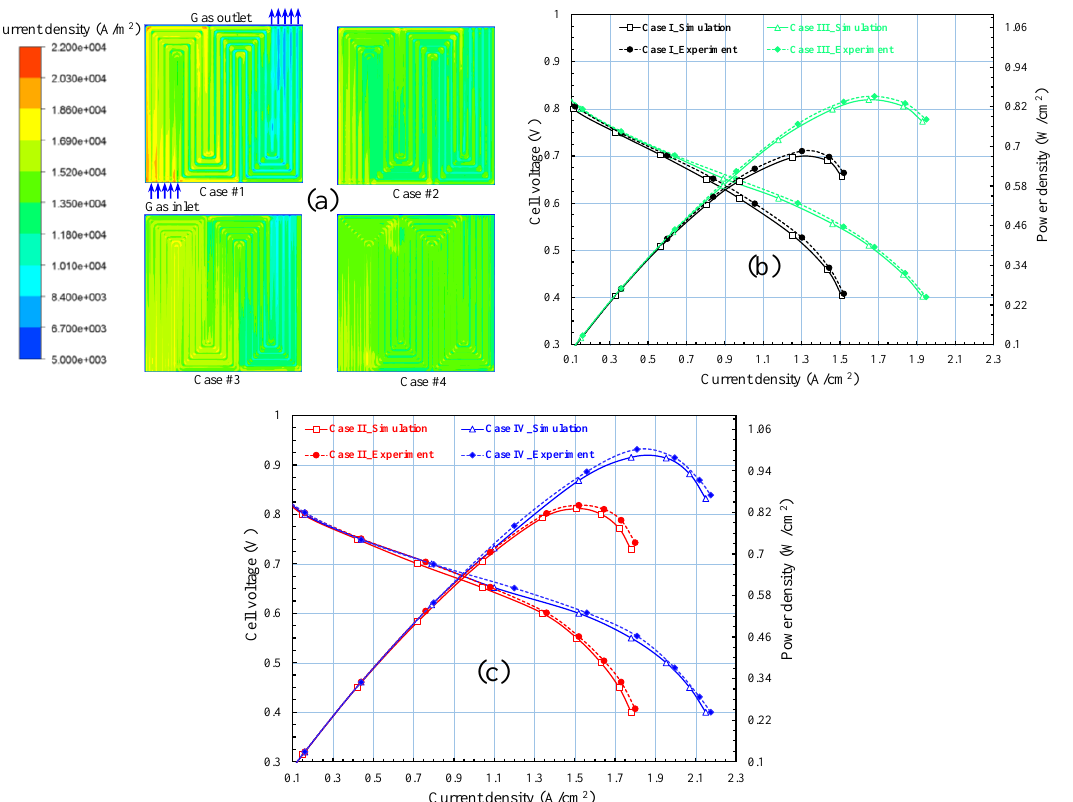
Figure 7. Comparisons of ( a ) current density distributions on a 25-cm 2 active area at an average current density of 1.2 A/cm 2 ; ( b ) performance curves of different simulation configurations I–IV obtained by numerical simulation and experimental testing using constant stoichiometry ratios of the supply gases; and ( c ) performance curves of different simulation configurations I–IV obtained by numerical simulation and experimental testing using constant mass flow rates.